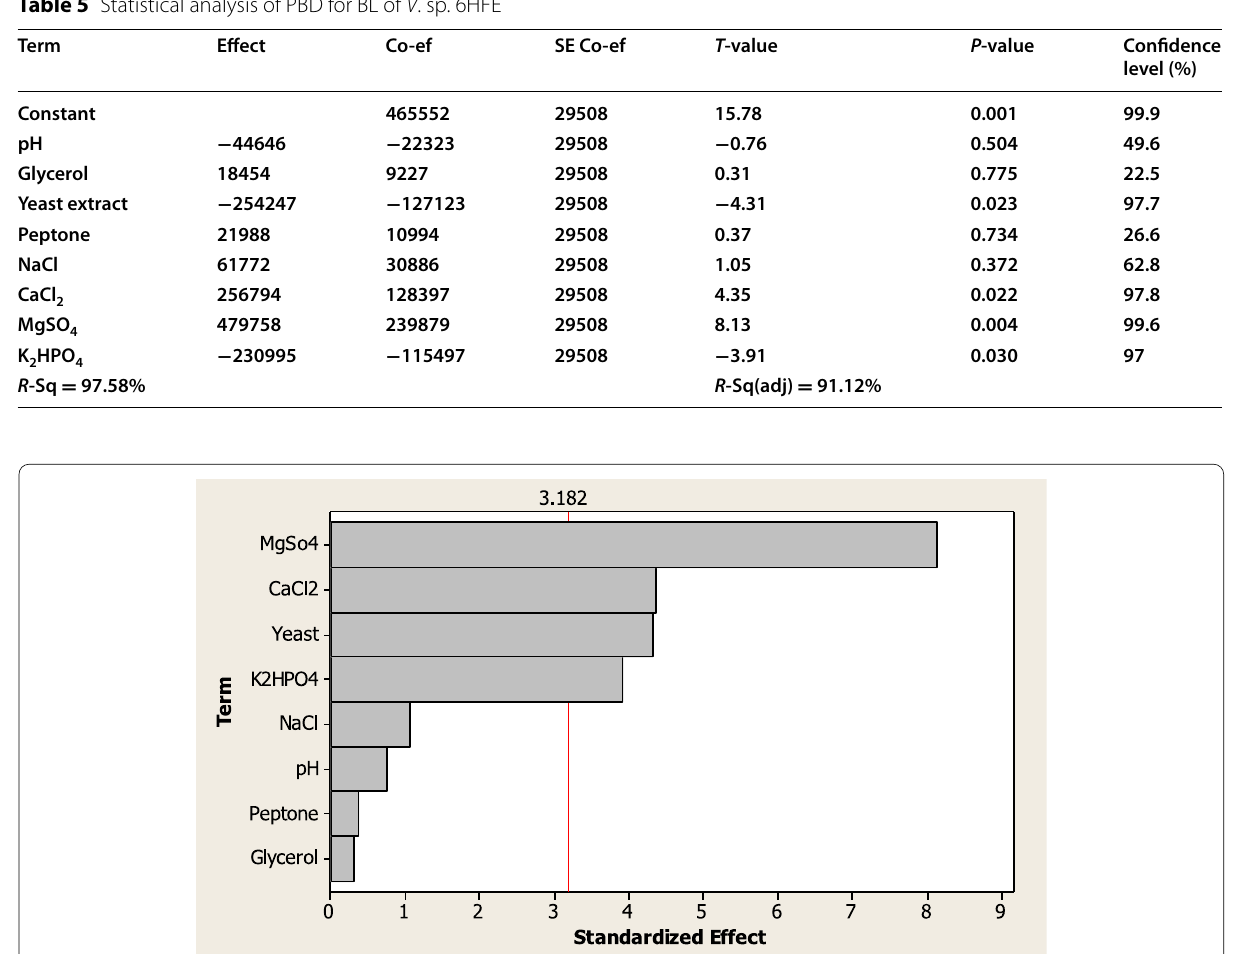
Fig. 4 Pareto chart showed the independent variables influencing the bioluminescence of Vibrio sp. 6HFE